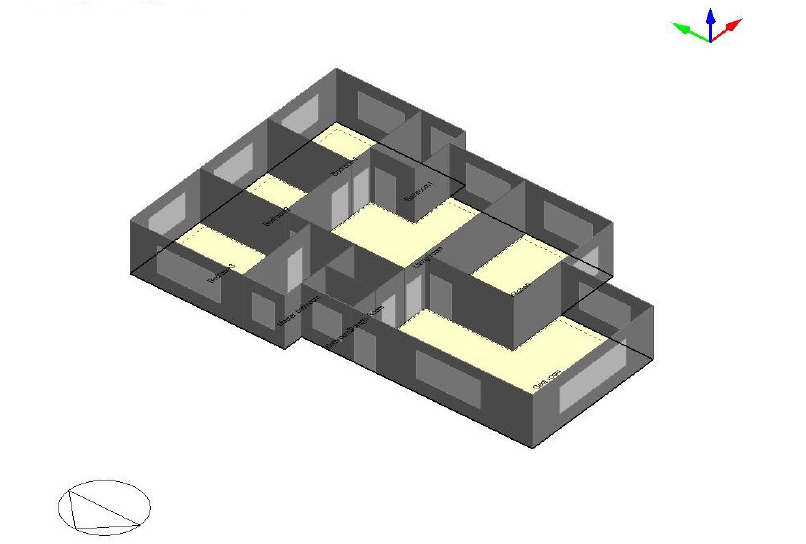
Fig. 1. Overview of baseline